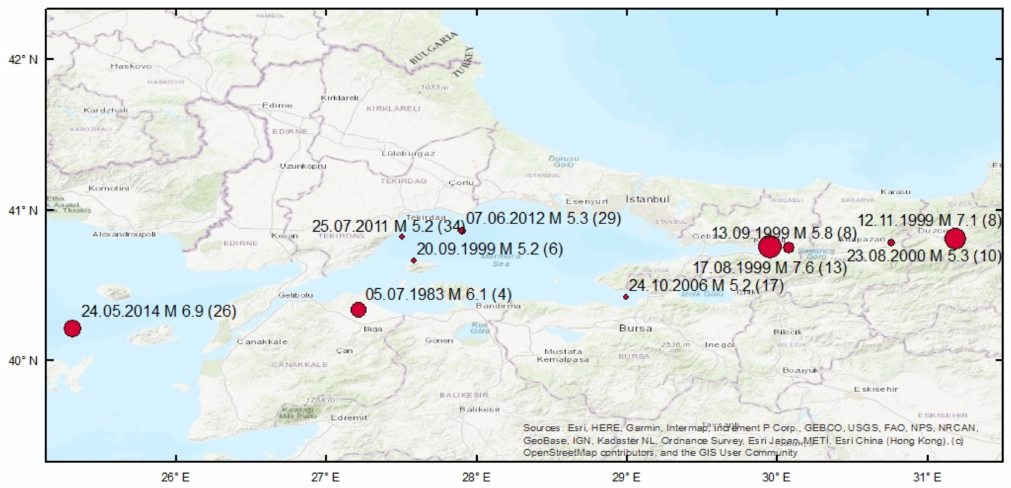
Figure 11. Earthquakes used to evaluate the applicability of GMPEs. Numbers in parentheses indicate the number of recordings for each earthquake within 250 km distance in our study